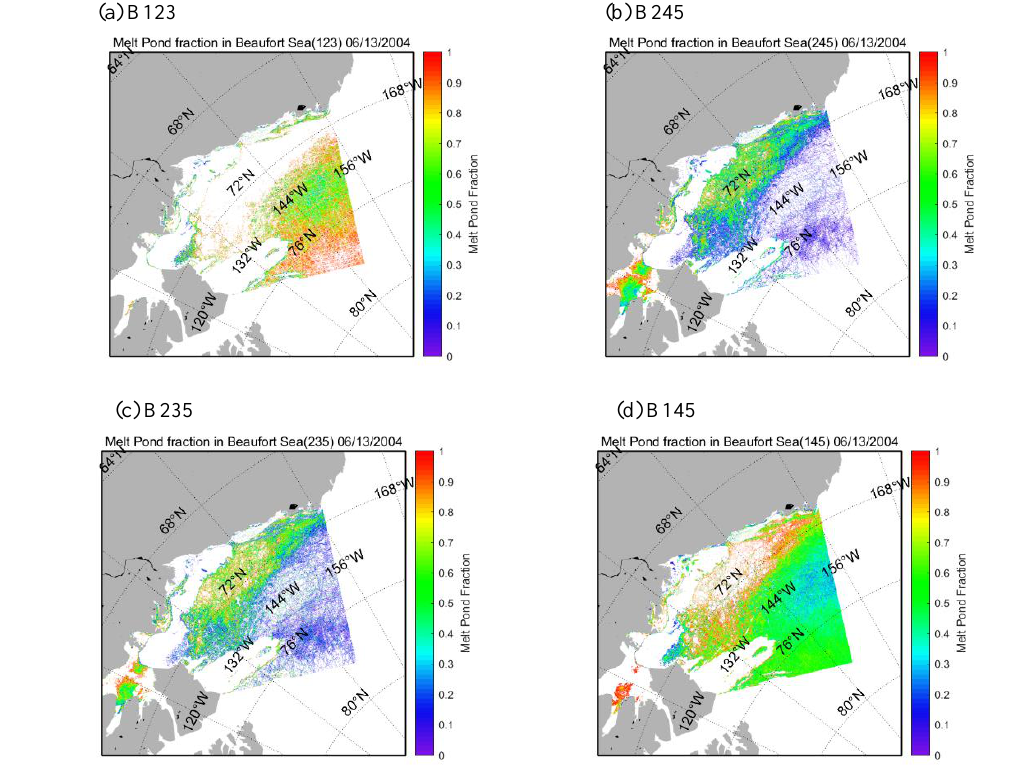
Figure 2. MPF retrieval result using three-band algorithm in different combination